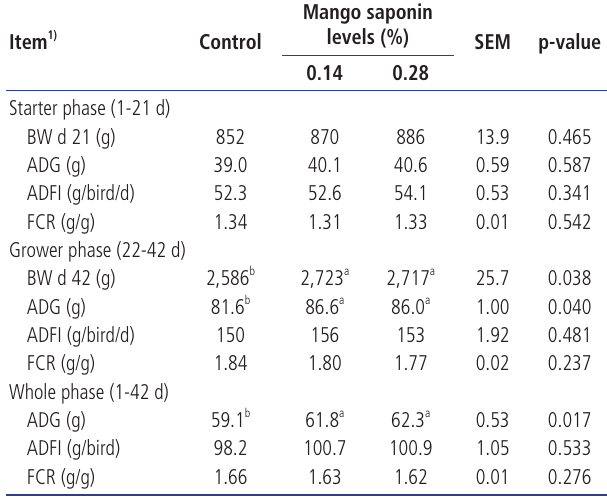
Table 2. Effect of dietary mango saponin supplementation on growth performance of broiler